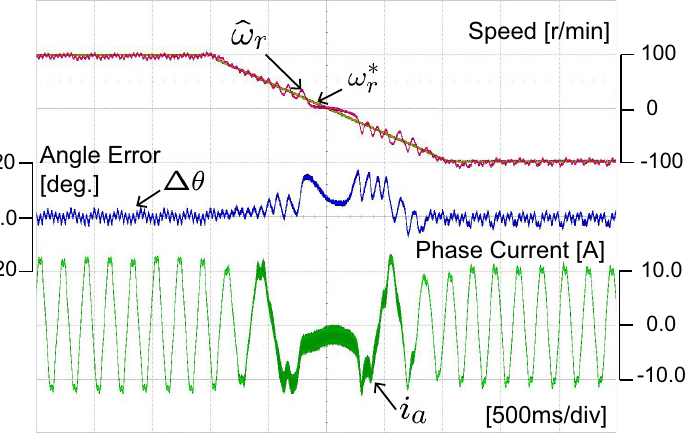
Figure 11. Speed transition under no load condition from 100 to − 100 r/min under 1.0 pu load.